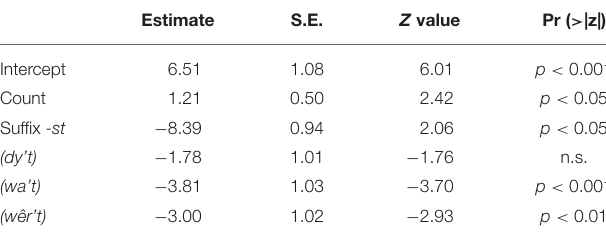
TABLE 9 | Optimal model for substitution of Frisian relative pronouns dy’t , dêr’t , wêr’t, and wa’t in Twitter data for FreqvarH, i.e., Twitterers who frequently produced the variable (range = 106–626) in their tweets) ( n = 3,448, N = 14).